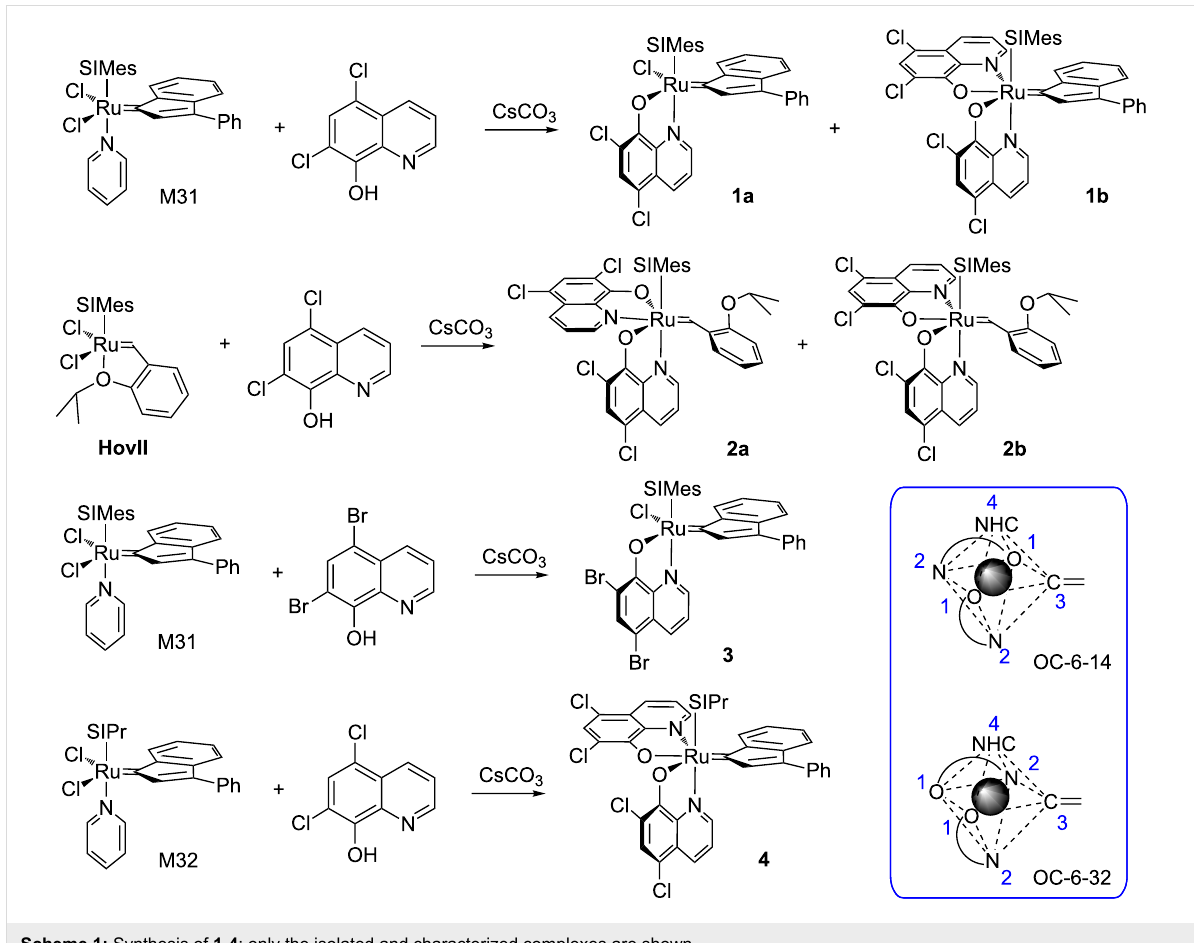
Scheme 1: Synthesis of 1 - 4 ; only the isolated and characterized complexes are shown.